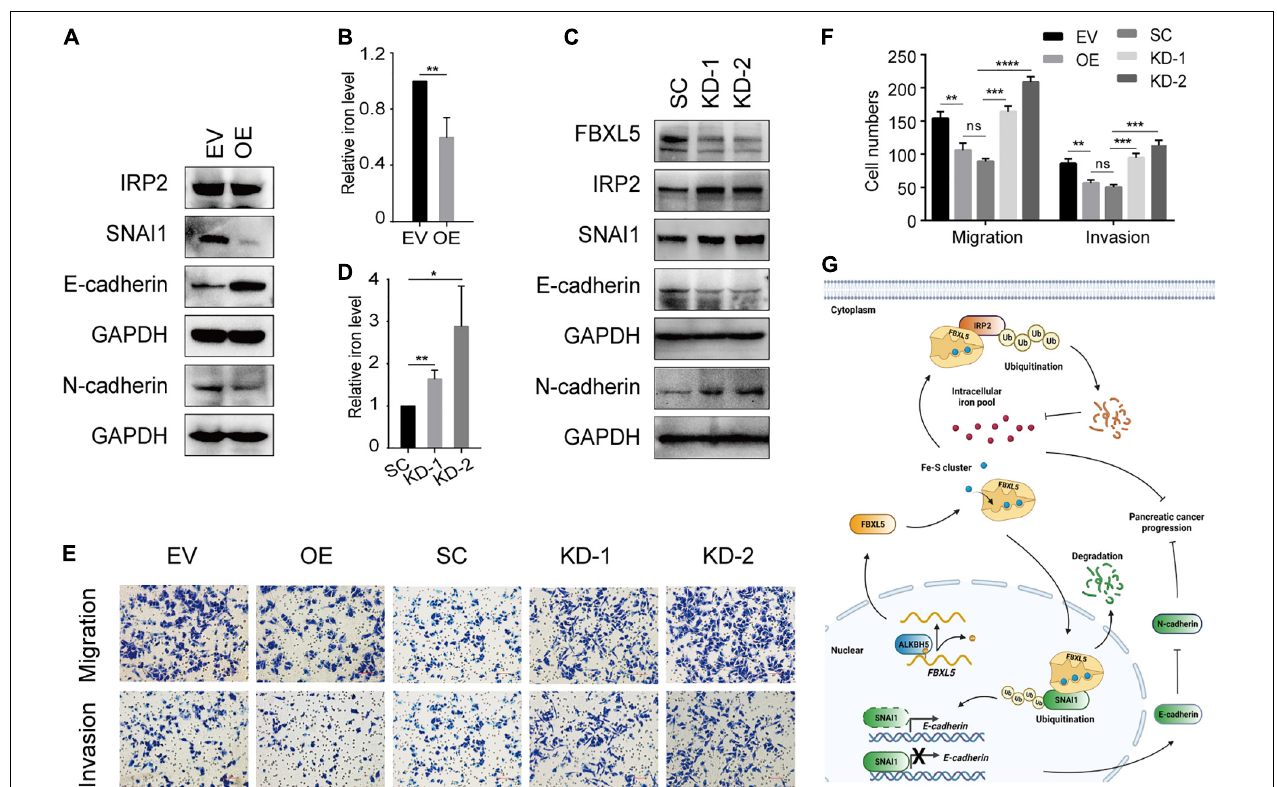
FIGURE 7 | ALKBH5 protects against tumor progression in PDAC by targeting regulators of iron metabolism. (A) Western blot analysis showing the expressions of IRP2, SNAI1, E-cadherin, and N-cadherin in ALKBH5-overexpressing cells. EV, empty vector; OE, ALKBH5-overexpressing cells. GAPDH is used as an internal control. (B) Intracellular iron assay showing the effect of ALKBH5 overexpression on intracellular iron levels. (C) Western blot analysis showing the effect of FBXL5 knockdown in rescuing the expression of IRP2, SNAI1, E-cadherin, and N-cadherin in ALKBH5-overexpressing cells. SC, scramble control; KD-1, FBXL5 knockdown-1; KD-2, FBXL5 knockdown-2. (D) Intracellular iron assay showing the effect of FBXL5 knockdown in restoring intracellular iron levels in ALBKH5-overexpressing cells. (E) Cell migration and invasion assays of FBXL5 knockdown in OE. (F) Statistical analysis for the result of transwell assays in (E) . Cell numbers per field were presented as the mean ± SD. * P < 0.05, ** P < 0.01, *** P < 0.001, **** P < 0.0001. (G) Schematic diagram depicting the role of ALKBH5 in attenuating pancreatic tumorigenesis through targeting regulators of iron metabolism. (Created with